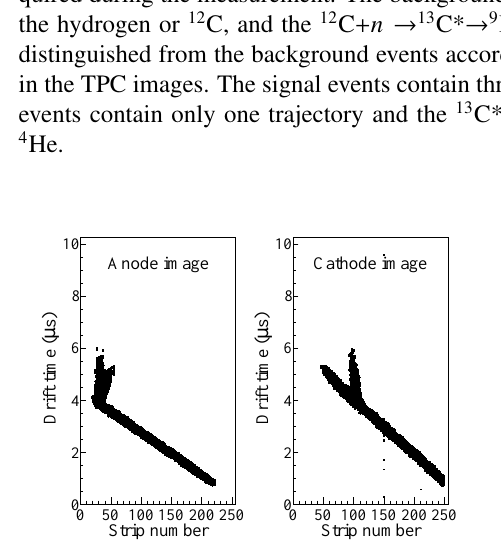
Figure 3. Scatter plot of the kinetic energy and angle of the recoil 12 C. The solid line represents the calculated energy and angle for the 0 +